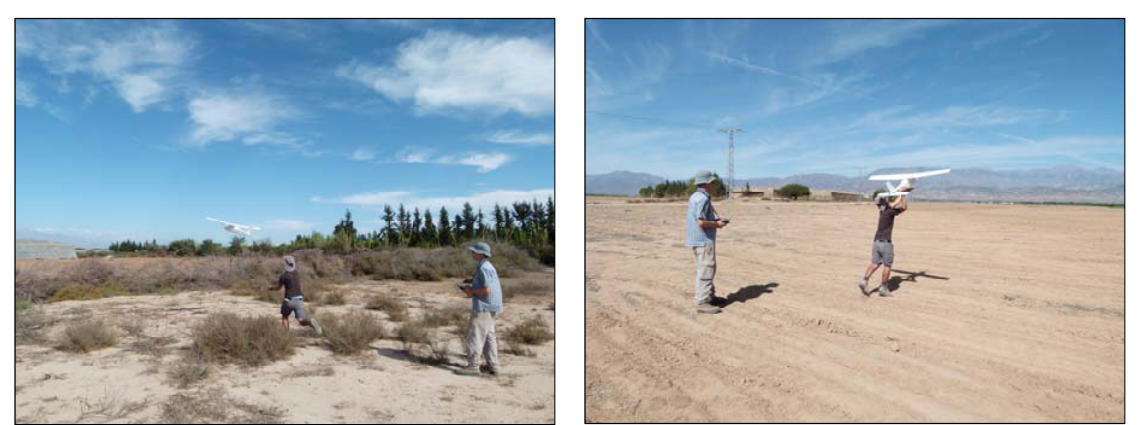
Figure 3. Fixed-wing aircraft Sirius I by MAVinci (Photo: W. d’Oleire-Oltmanns